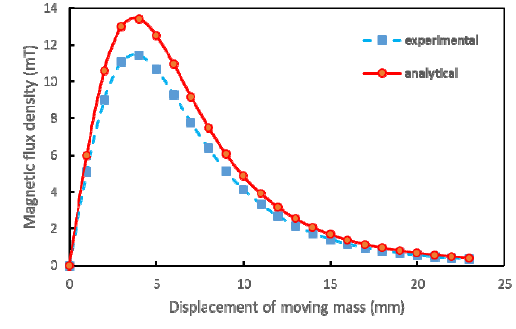
Figure 9. Variation of the magnetic flux density